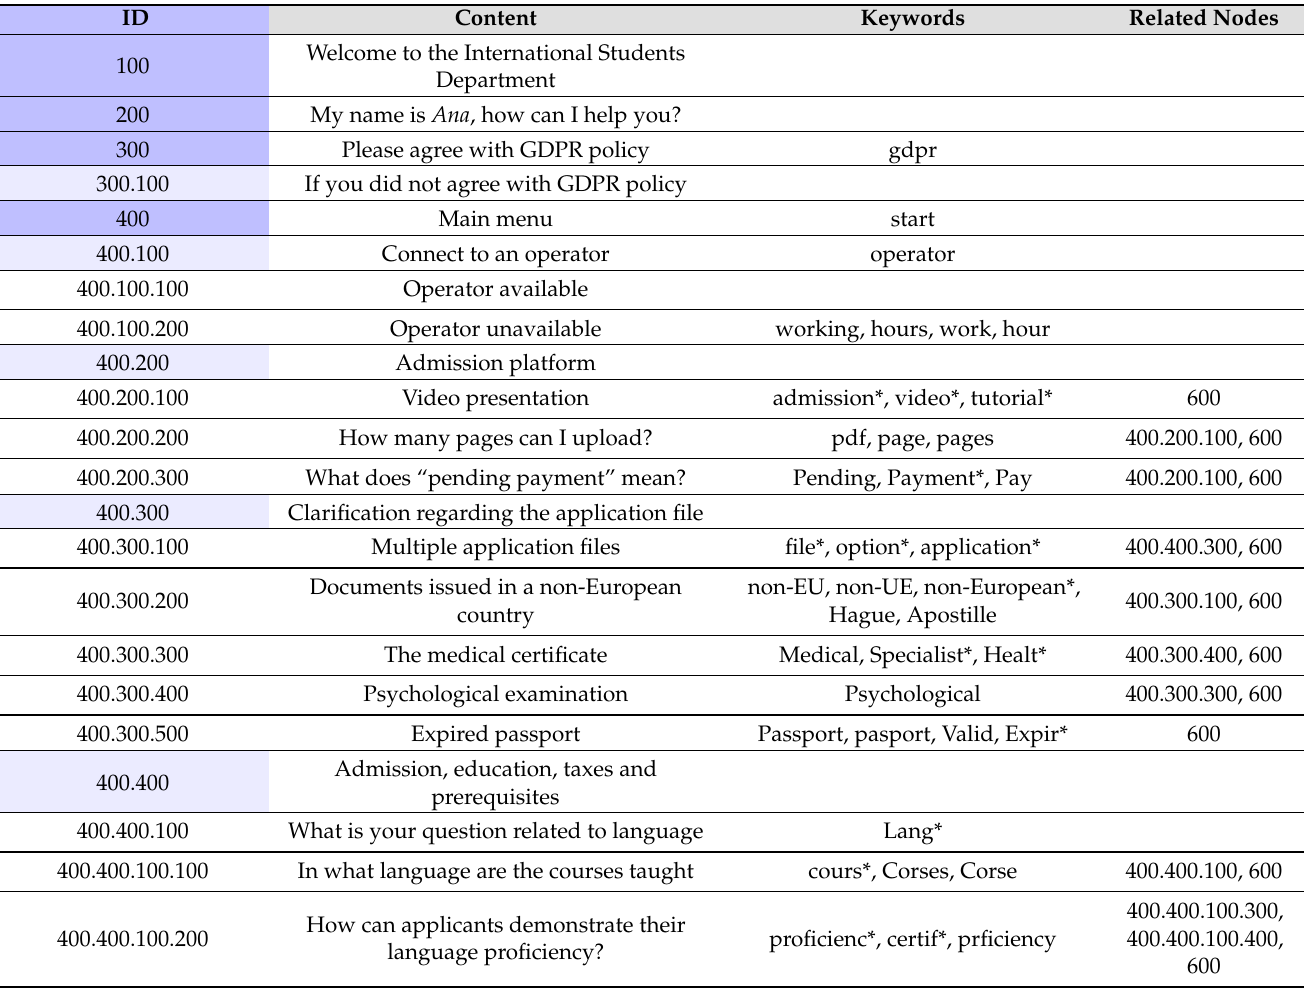
Table 1. The questions known by the chatbot